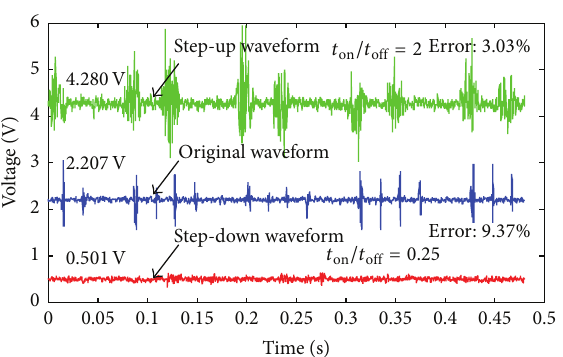
Figure 8: Comparison between original DC waveform and wave- forms output from enhanced circuit.